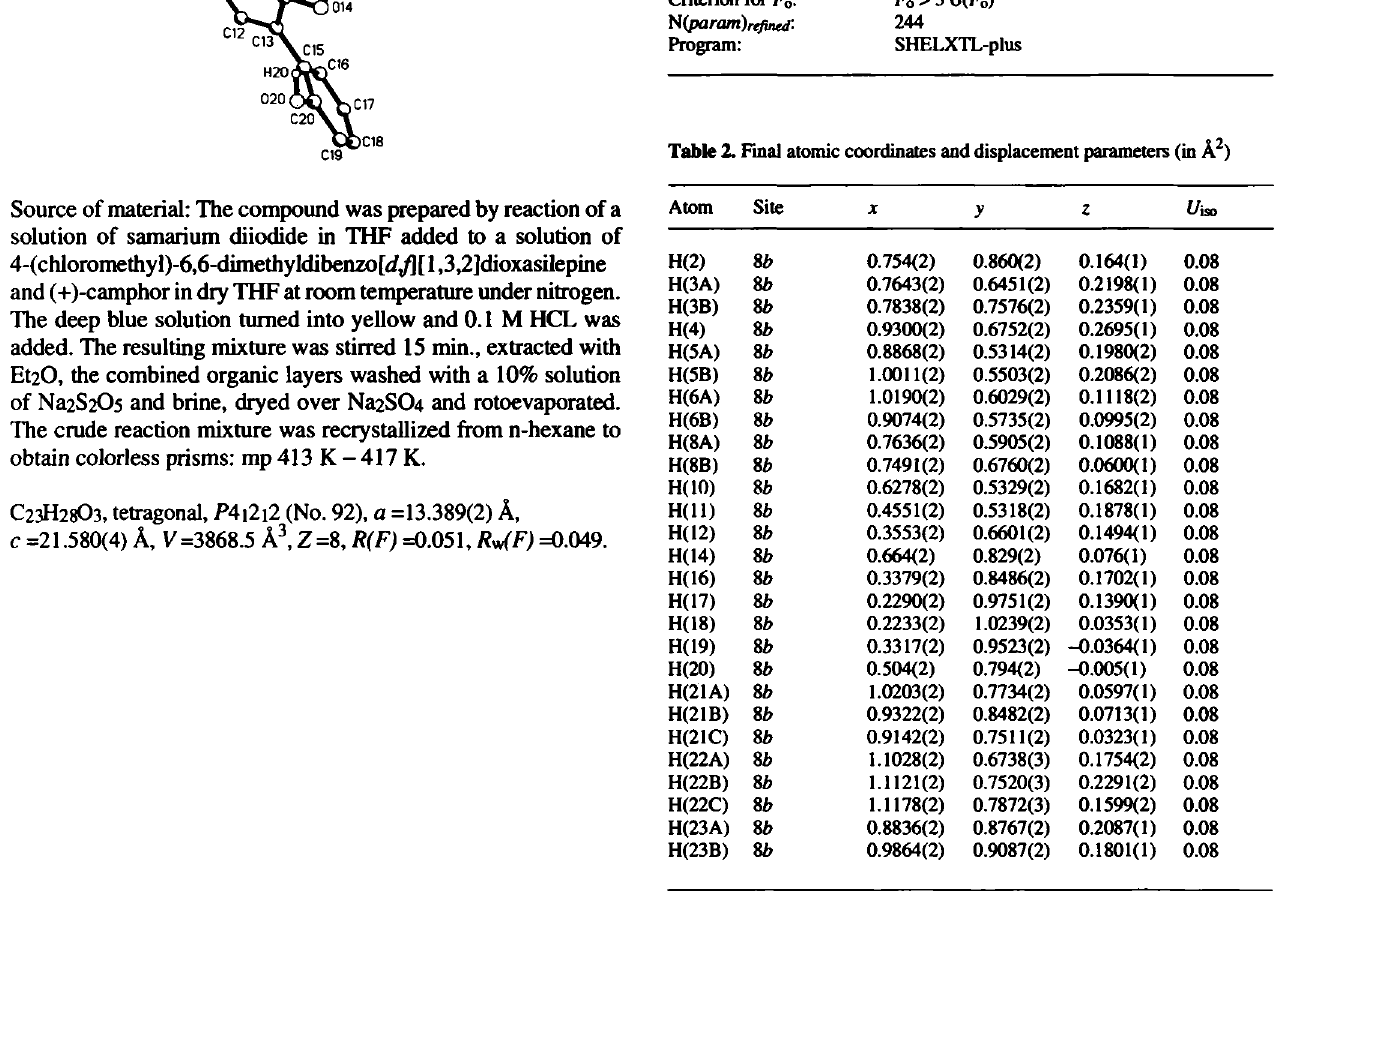
Table 1. Parameters used for the X-ray data collection